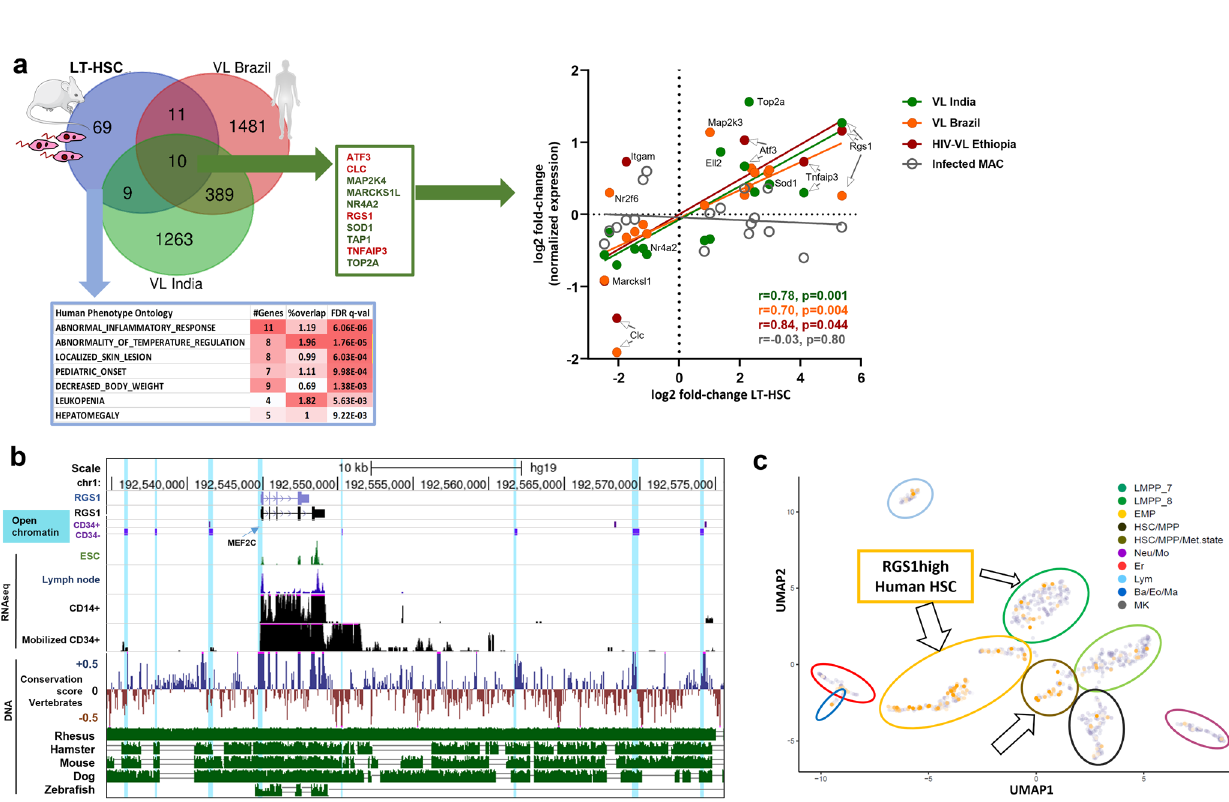
Fig. 6 An evolutionary conserved StemLeish gene signature recapitulates cross-species epigenetic and transcriptional signatures of visceral leishmaniasis. a In vivo validation of StemLeish signature in three independent cohorts of human VL patients from Brazil, from India and HIV-VL co-infected patients from Ethiopia, all fold-changes of DEG from untreated patients with active disease vs . post-treatment blood samples. Venn diagram (upper left panel) shows overlap between murine and human signatures. Human Phenotype Ontology (MSigDb) enrichment analysis indicates the StemLeish signature phenocopies the complete clinical picture of human VL (lower left panel). Signi fi cant correlations (Spearman) between StemLeish and human VL DEG in all three cohorts (right panel). b Integrated epigenetic, transcriptomic and genomic analysis of the Rgs1 locus, visualized in UCSC Gene browser. Open chromatin regions (DNase I Hypersensitive Sites) in puri fi ed CD34 + HSC (indicated as CD34 + ) and HSC undergoing myeloid differentiation (indicated as CD34 − ) are indicated by light blue shades. Transcriptomic data (RNAseq) represent mapped reads present in puri fi ed CD14 + vs. puri fi ed mobilized CD34 + cells, with embryonic stem cells (ESC) and lymph node RNAseq data plotted for comparison. Genomic data show conservation score across 100 different vertebrate species (blue: conserved, brown: not conserved), with leishmaniasis and tuberculosis model species (rhesus macaques, mouse, hamster, dog, zebra fi sh) plotted individually (green panels below), as compared to the human reference genome. c Reanalysis of single-cell RNAseq data 50 using UMAP (Unifold Mapping) revealed presence within puri fi ed human CD34 + cells of an RGS1 high phenotype in several progenitor subsets [Erythro-Myeloid Progenitors (EMP), Lymphoid/Myeloid Progenitors (LMPP7), HSC in a metabolically active state (HSC/Met. state)]. Arrows demonstrate clusters containing RGS1 high cells (orange vs. gray RGS1 low cells). Arrow sizes are proportional to the frequency of RGS1 high cells. Clipart used in diagram ( a ) was obtained from Servier Medical Art